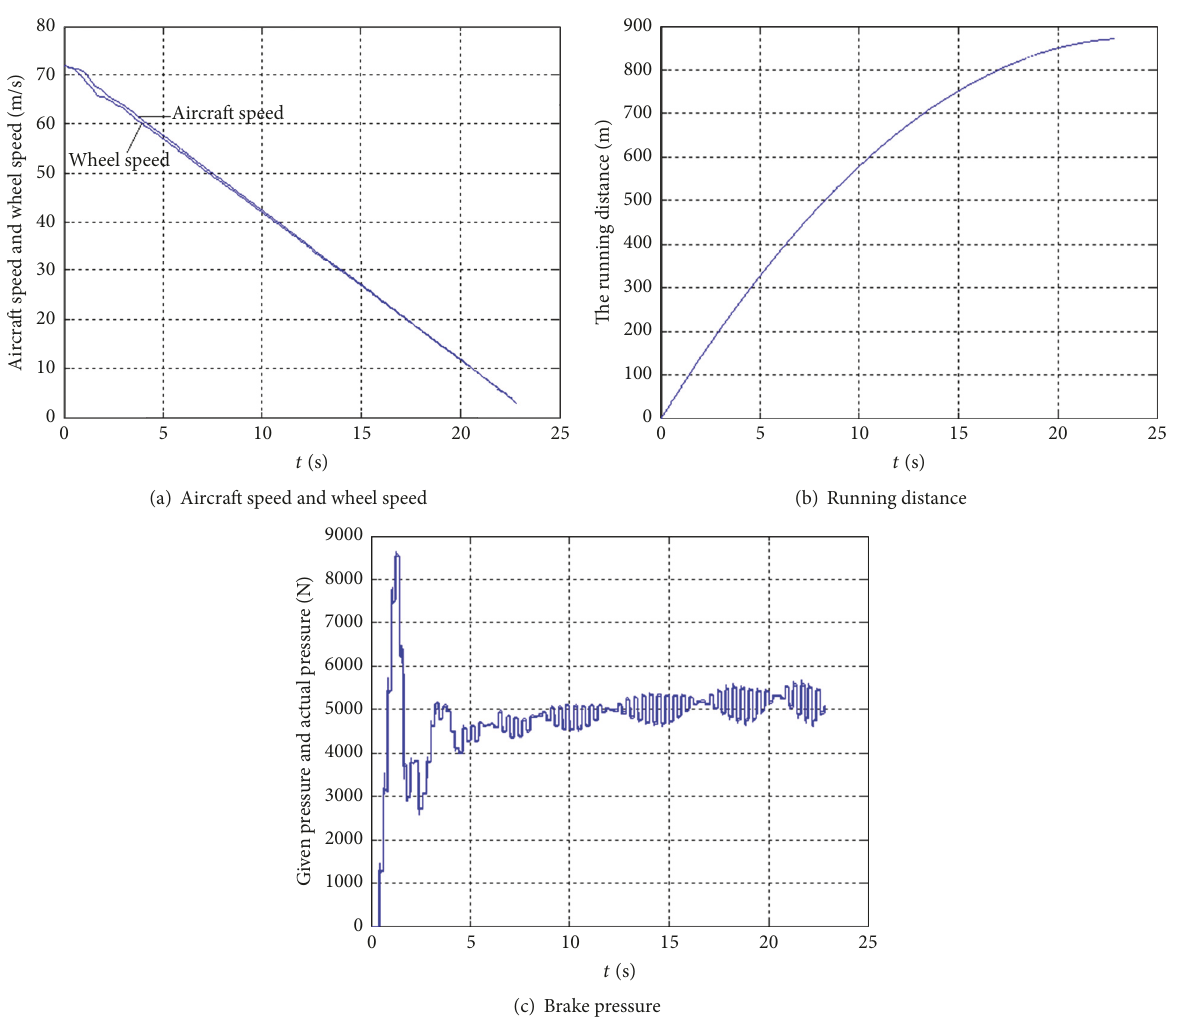
Figure 11: Simulation results when deceleration rate is